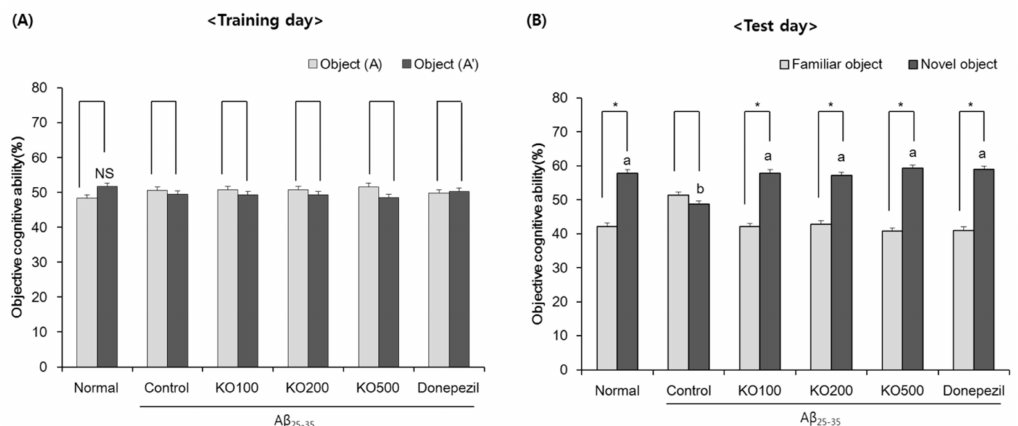
Figure 2. Novel object recognition test. ( A ) The percentage of time exploring of the identical two objects in the training day. ( B ) The percentage of time exploring of the familiar and novel object in the test day. Normal, injection of saline solution + oral administration of water; Control, injection of A β 25–35 + oral administration of water; KO100, injection of A β 25–35 + oral administration of KO at 100 mg / kg / day; KO200, injection of A β 25–35 + oral administration of KO at 200 mg / kg / day; KO500, injection of A β 25–35 + oral administration of KO at 500 mg / kg / day; Donepezil, injection of A β + oral administration of 25–35 donepezil at 5 mg / kg / day. Values are represented as means ± SD ( n = 8). * The object cognitive abilities for familiar and novel objects are significantly di ff erent as determined by Student’s t -test ( p < 0.05). a,b Means with the di ff erent letters are significantly di ff erent ( p < 0.05) by Duncan’s multiple range test. NS,